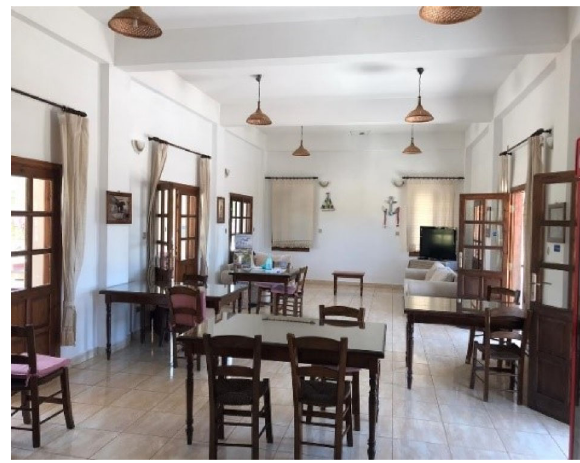
Fig. 22 Glaro Garden Hotel. Ceiling and fl oor sample — table with legs made on a wood lathe and woven straw chairs are placed in the dining areas (Figs. 19 – 22).